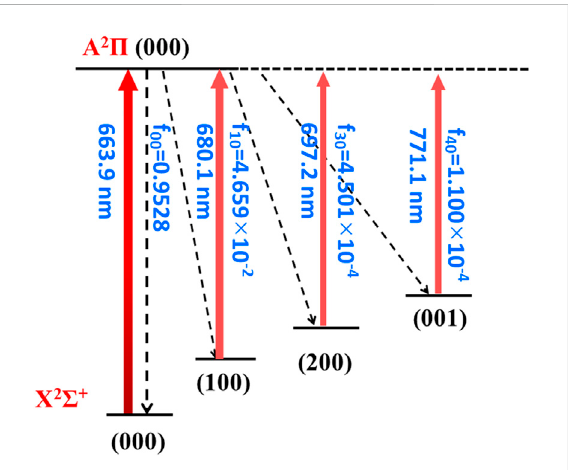
FIGURE 5 The constructed cooling scheme for SrNC using the A 2 Π The rotational branching can be eliminated by driving the J = 1 → J ’ = 0